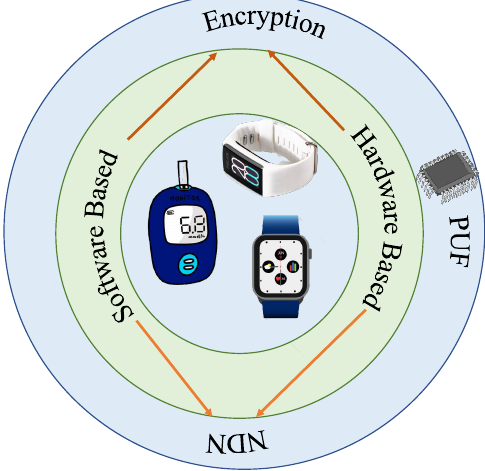
Figure 10. Security